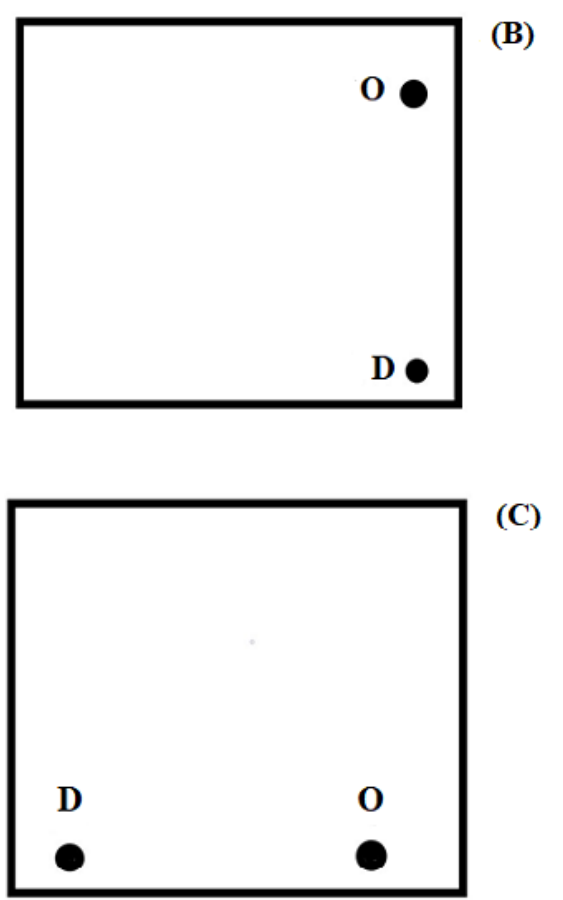
Figure 8. Chromatographic plate: ( A ) with DicloDuo Combi extract (S) or a mixture of diclofenac sodium and omeprazole standards (S) applied; ( B ) plate ( A ) after development in the mobile phase chloroform–methanol–ammonia (36:4:0.60, v / v / v ); D—a spot representing diclofenac sodium, O—omeprazole; ( C ) the plate ( B ) was rotated by an angle of 90 o to develop in the mobile phase cyclohexane – chloroform – methanol – glacial acetic acid (6:3:0.5:0.5, v / v / v / v ).